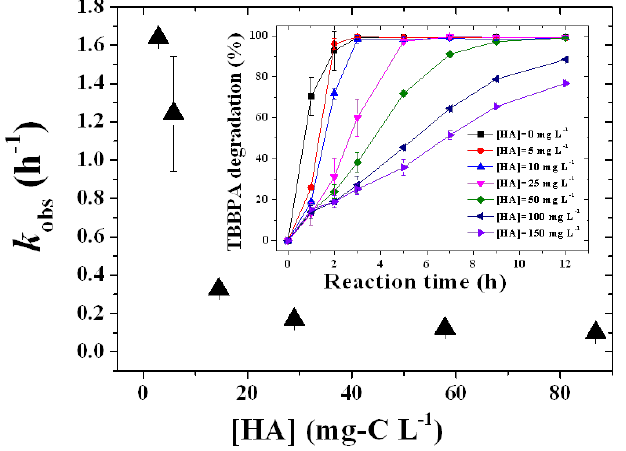
Figure 6. Influence of HA concentration on the pseudo-first-order rate constant ( k TBBPA degradation and variations in the percent TBBPA degradation (insertion). The reaction conditions were as follow: [TBBPA] [KHSO ], 1.0 mM; pH = 8; temperature, 25 5